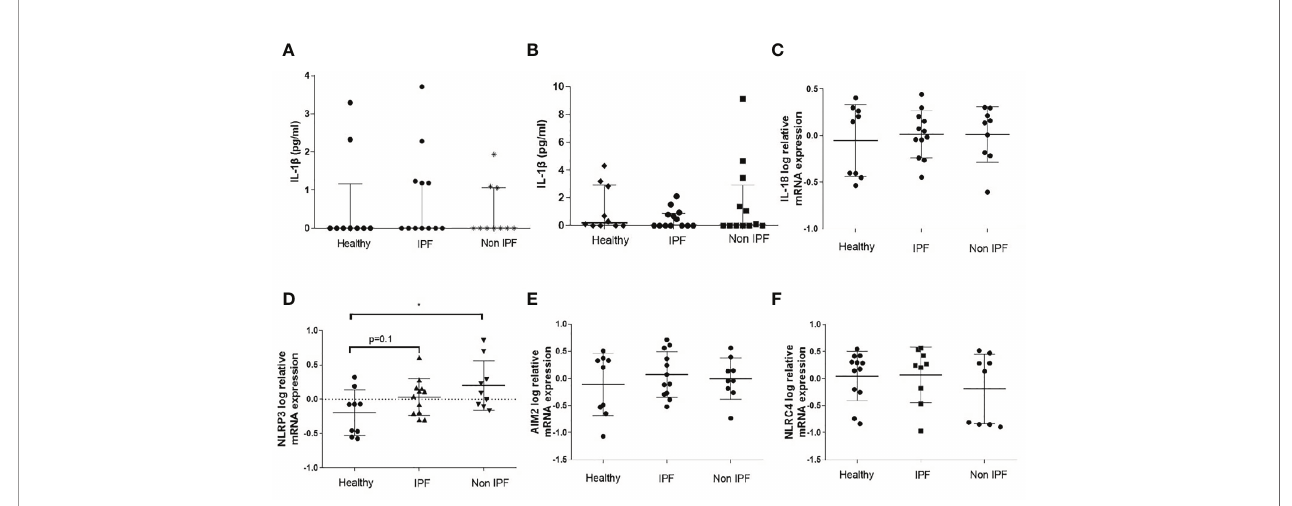
FIGURE 1 | Baseline characterization of the In fl ammasome in BALF cells. (A) IL-1 b protein concentration in BAL fl uid as measured by ELISA and (B) IL-1 b protein release by unstimulated AMs (5-hour culture). Data represented as median with interquartile range Mann-Whitney test. Relative log mRNA expression in unstimulated BALF cells (C) IL18 (D) NLRP3 , (E) AIM2 , (F) NLRC4 . Data represented as mean ± SD, t-test.